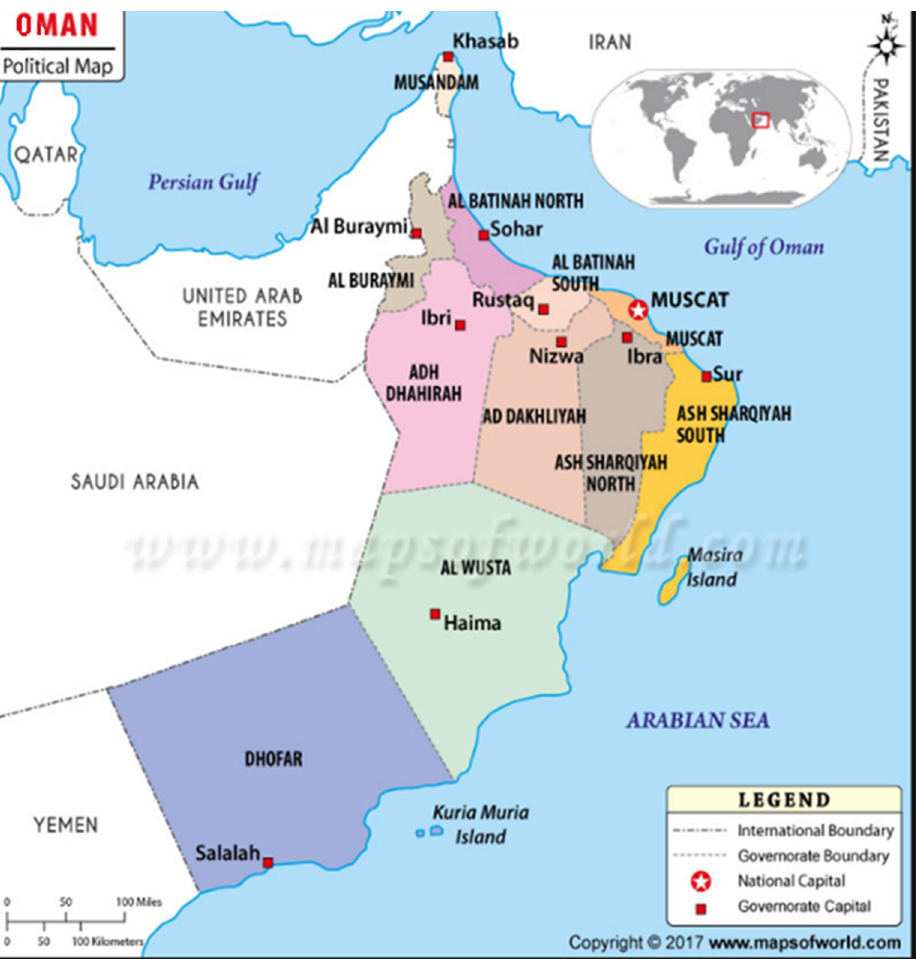
Figure 1. Map of Oman.